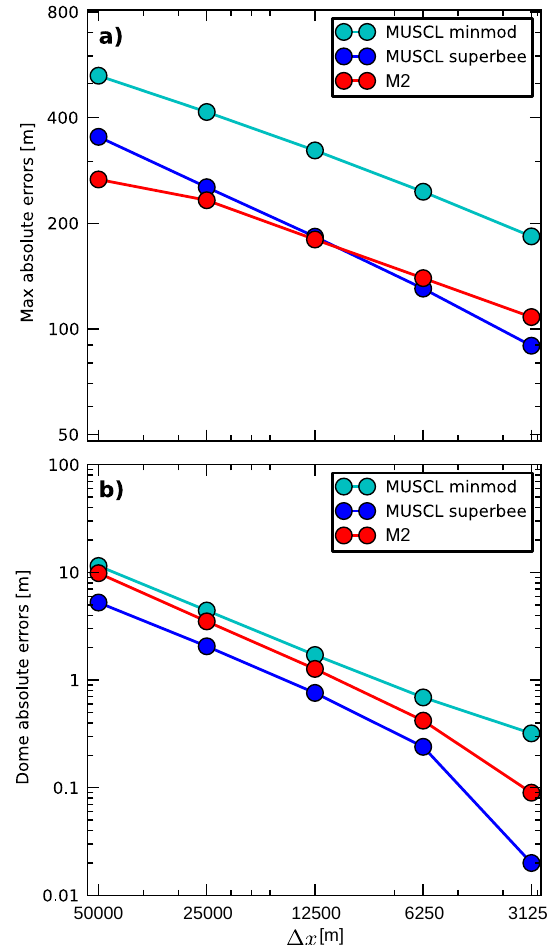
Fig. 5. Results of the Bueler C benchmark (cf. Sect. 7.2) for increas- ing spatial resolution on a log-log scale. The maximum error in the whole domain, e max , is displayed in (a) , and (b) shows the central dome height error e dome